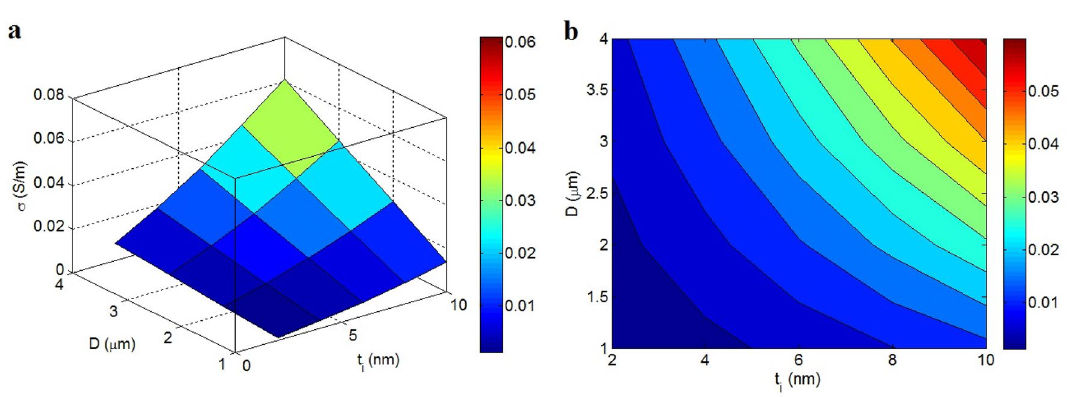
Figure 4. Disparities of conductivity at dissimilar arrays of ϕ f and σ f : ( a ) 3D and ( b ) contour strategies.